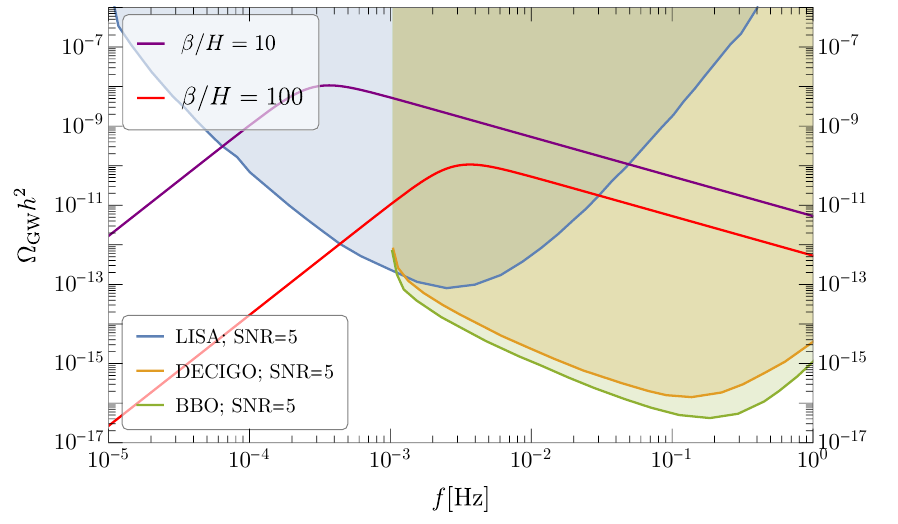
Figure 8. The spectrum of GW abundance Ω GW h 2 as a function of GW frequency f from bubble collisions. We choose two sets of benchmark parameters ( β/H = 10 , T c = TeV) and ( β/H = 100 , T c = TeV). The projected sensitivity of LISA, DECIGO and BBO experiments at Signal-to-Noise (SNR) = 5 are also